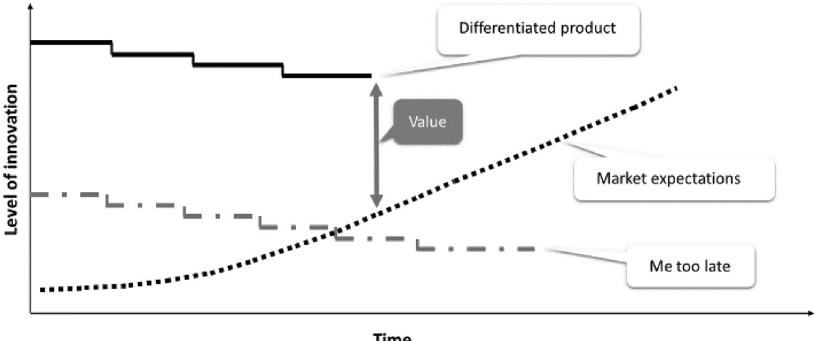
Fig. 1 The innovation threshold. Depicts the importance of embarking on a project that will meet market expectations 10 years or more from the time of initiation. The solid back line (top) represents the level of innovation of a differentiated product. The broken gray line (middle) represents the fate of a “ me too ” drug. The dotted line represents